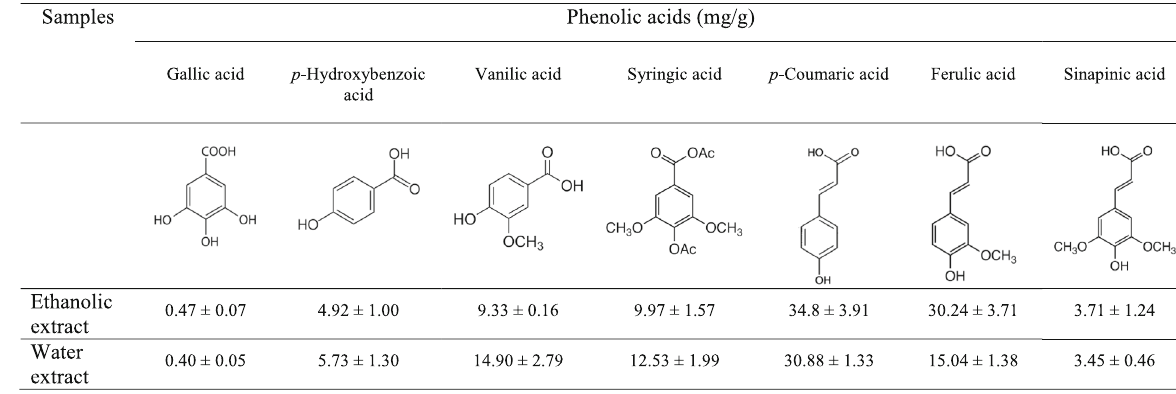
Table 1 Phenolic acid compositions of base hydrolyzed extracts of the powdered formula of H. cordata fermented broth and P. emblica